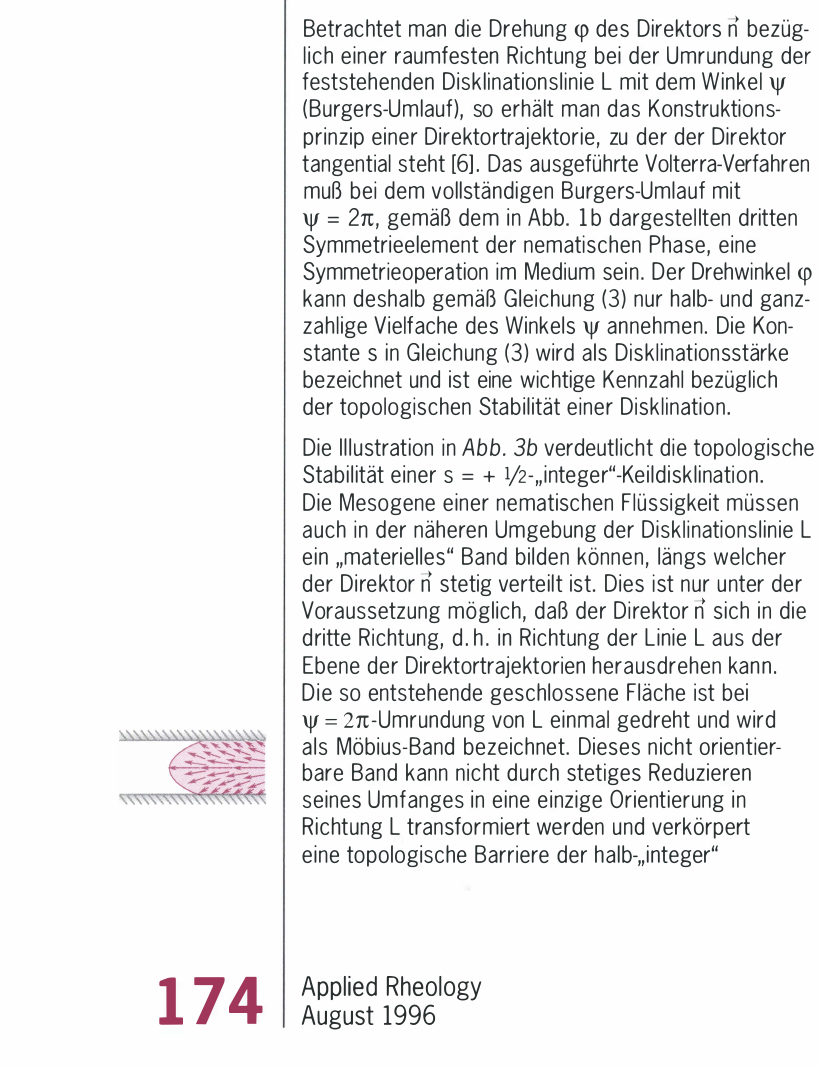
Fig. 3: a} Volterra process for straight wedge disclinations b) Three-dimensional representation of a wedge disclination in the nearest vicinity of L through a non­ orientable